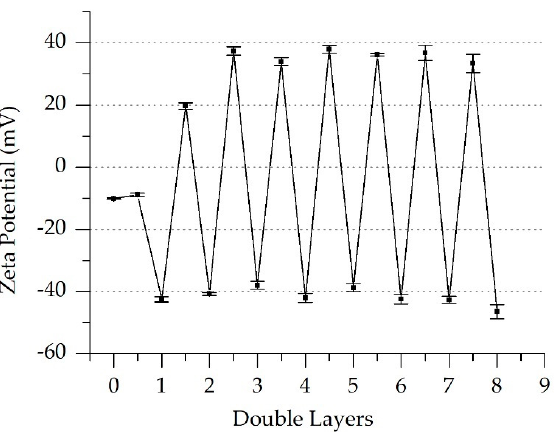
Figure 10. Zeta potential of a ceramic microparticle’s suspension in the presence of polyelectrolyte multilayers